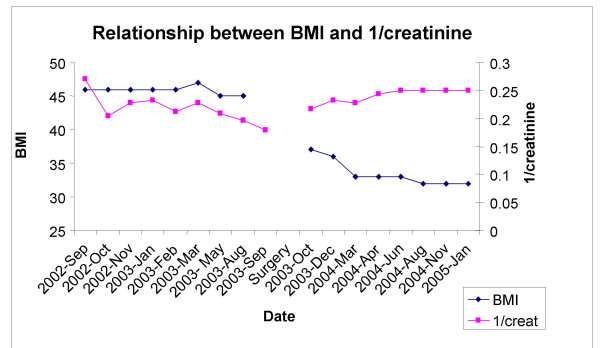
Relationship between renal function as 1/creatinine and BMI.